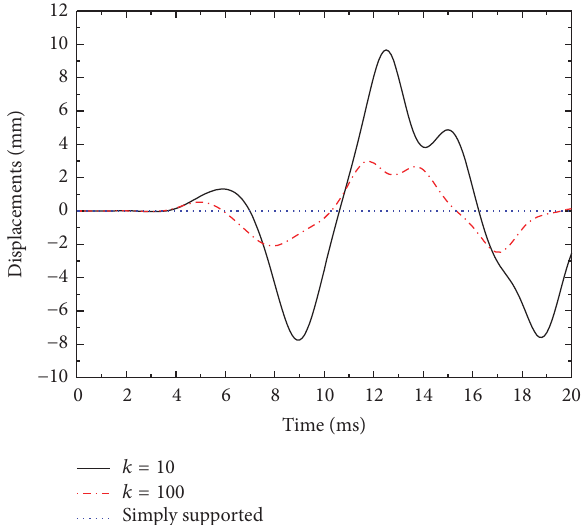
Figure11:Transversedisplacementhistoryatthecenterpoint(Node 43) with/without rotation